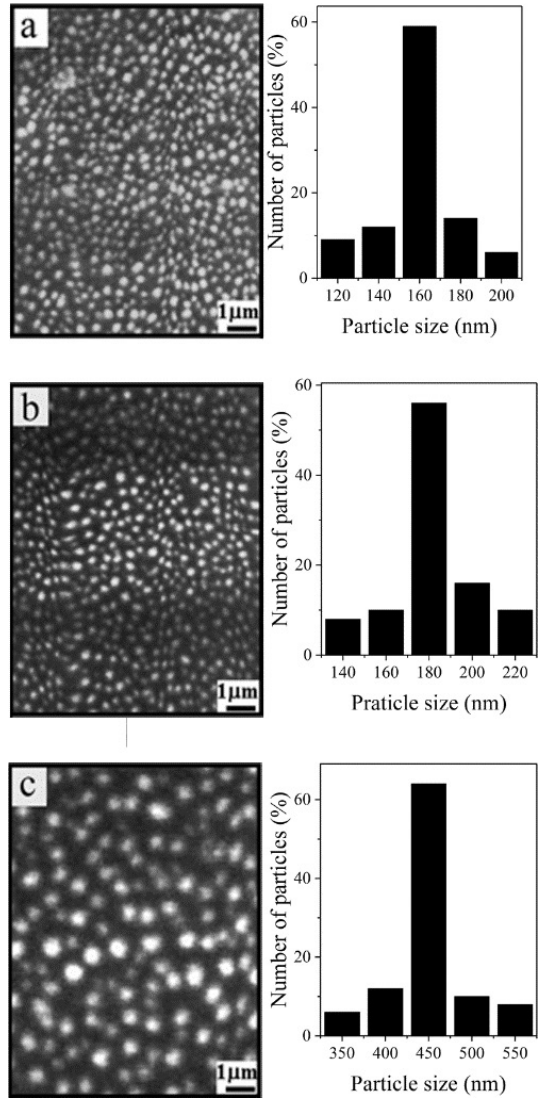
Figure 3: SEM images and size distribution of PWA particles of composite films PWA/P (2VPco1MA) (a), PWA/P (1VPco1MA) (b), and PWA/P (1VPco2MA) (c).